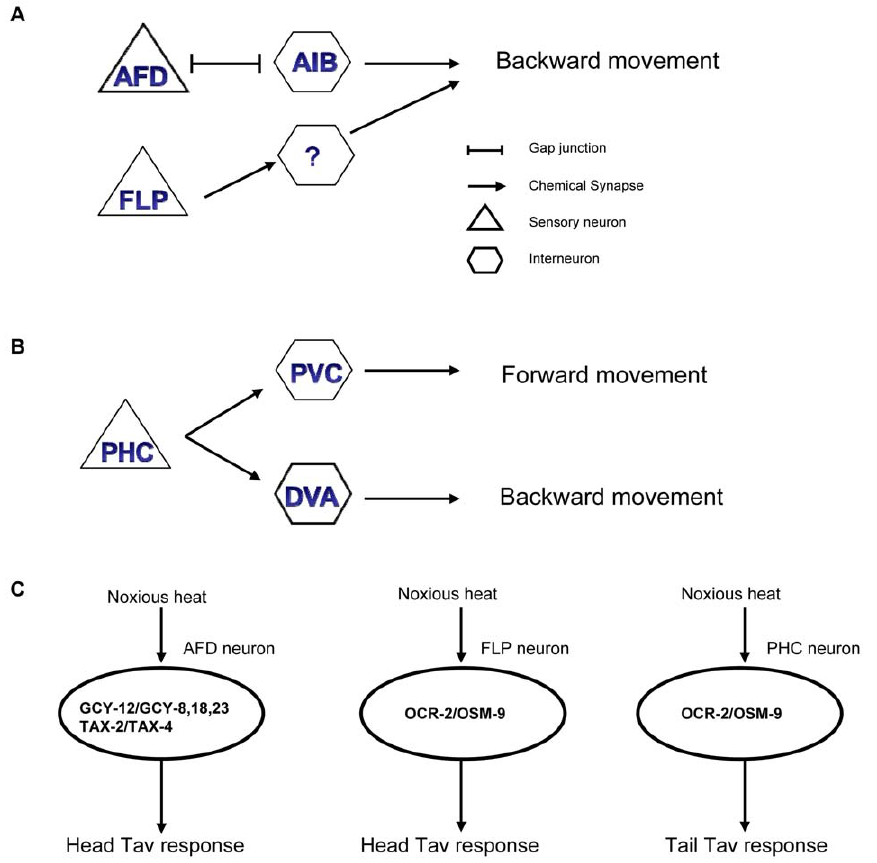
Figure 6. Models of noxious heat sensory neuron function. (A) Circuit diagram of head Tav response. AFD forms gap junction with AIB. (B) Circuit diagram of tail Tav response. (C) Genetic pathways contributing to Tav response. Head Tav response is mediated by a cGMP signaling pathway within the AFD neurons and a TRPV1 pathway in FLP, whereas the tail Tav response is mediated via TRPV1 in the PHC neurons.